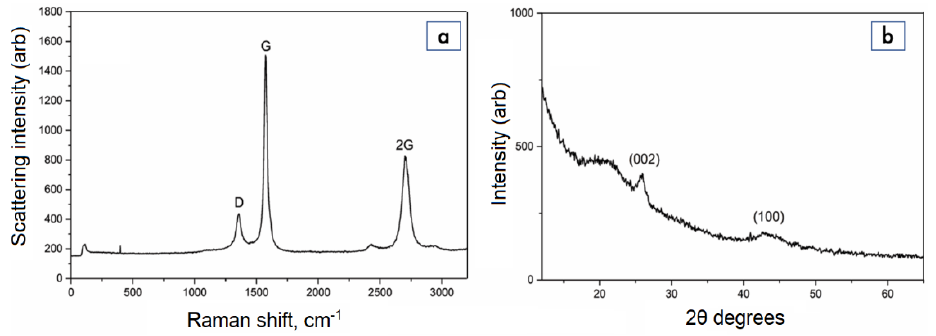
Figure 4. ( a ) Raman spectra and ( b ) XRD pattern of GLC.